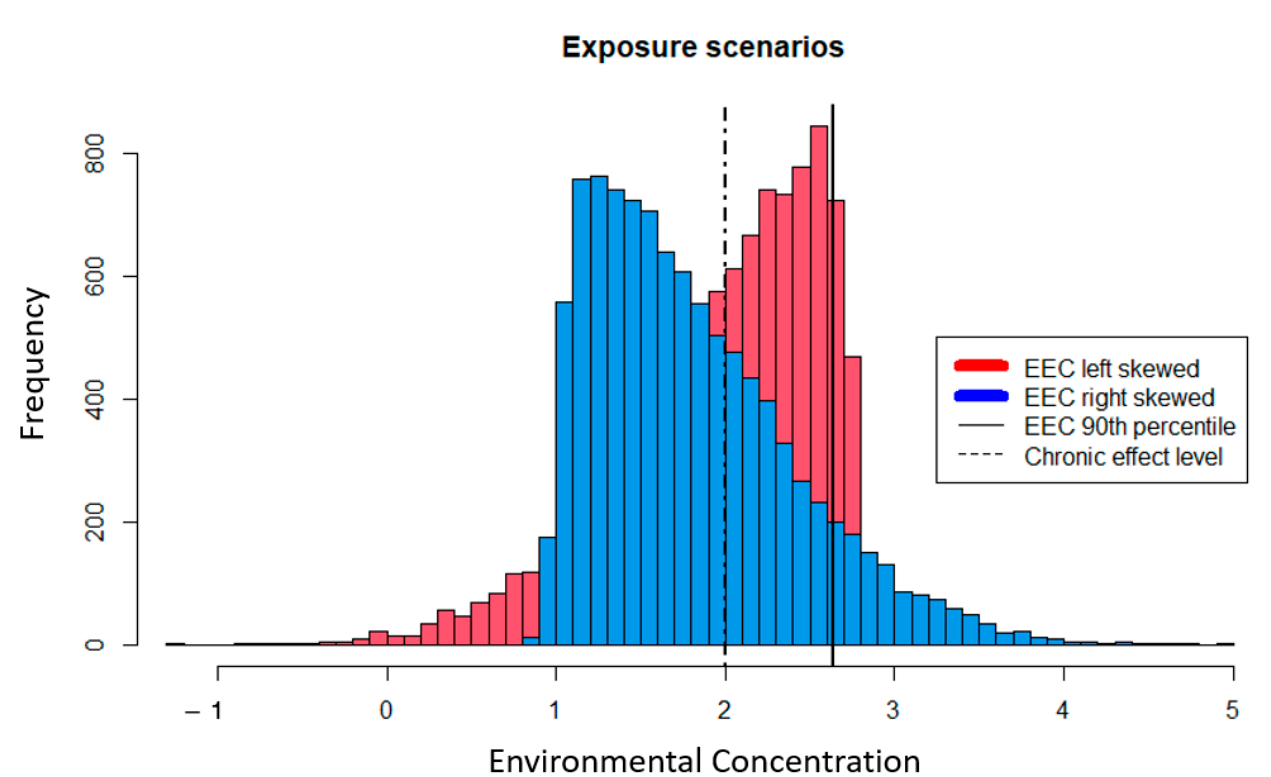
Figure 1. Hypothetical exposure profiles showing the frequency of chemical concentrations under different scenarios. Both distributions share the same 90th percentile noted by the solid line. A hypothetical chronic effect level is denoted by the dashed line for relative comparison of variable exposure profiles against a deterministic effect concentration.